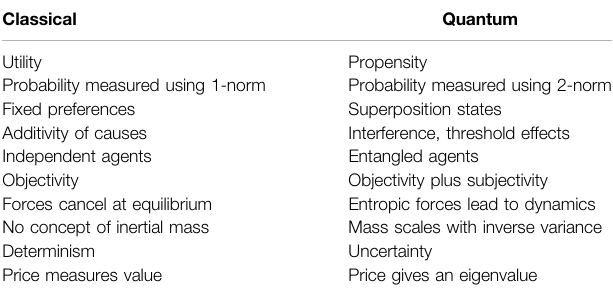
TABLE 3 | Comparison of the quantum and classical approaches.